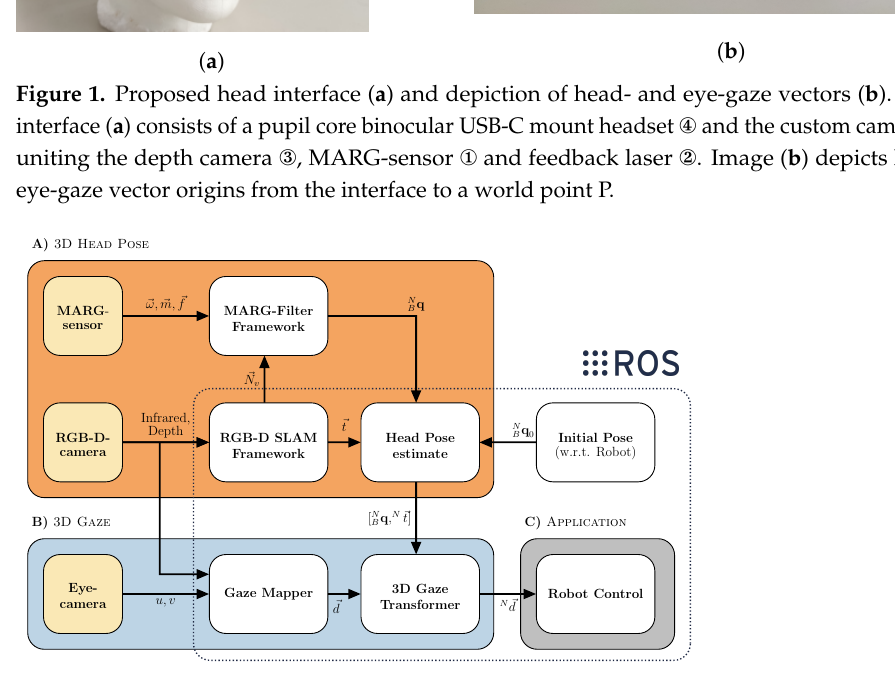
Figure 2. Block diagram of the overall system setup. The system consists of three main Soft- and Hardware components that enable the calculation of robust control signals for robotic teleoperation: ( A ) The accurate head pose estimation based on visual-inertial position and orientation estimation, ( B ) the calculation of 3D eye- and head-gaze from known head pose and gaze points from dense 3D depth images as well as ( C ) the application interface for robot control in 6D Cartesian